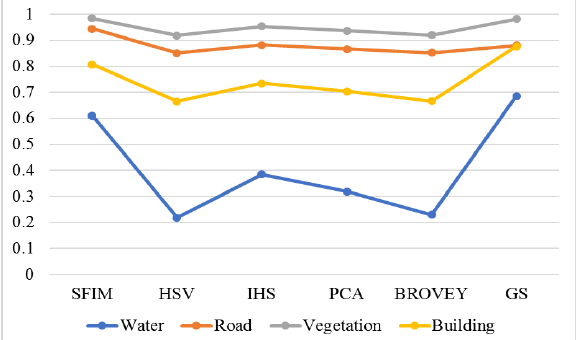
Figure 4. Correlation coefficients calculated for different land use types for Dataset 1